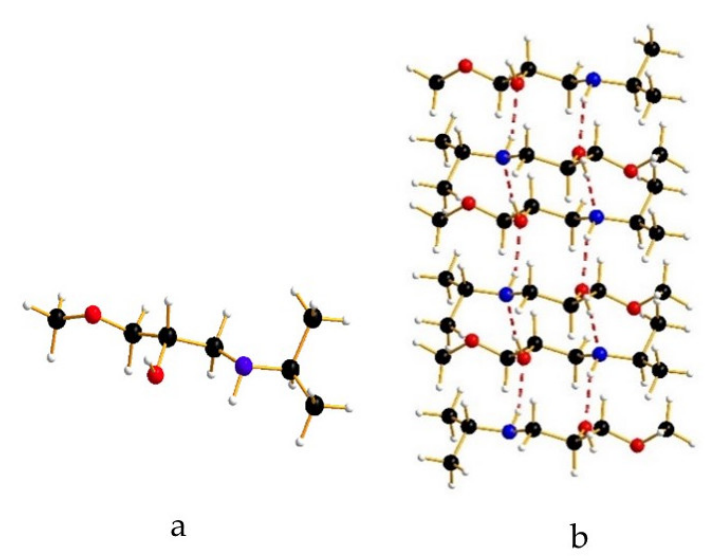
Figure 4. ( a ) Drawing of the simplified model, 1 ; ( b ) Optimized hydrogen bond column of 1 . The calculated equilibrium value for the column axis is 4.86 Å, a value consistent with the 5 Å identified as the limit for the elongation or shrinkage of the axis of the hydrogen bond column. Additionally, we optimized again the system fixing the axis between 4.20 Å and 5.50 Å. The energy variation is reported in Figure 5, showing how the shrinkage of the axis is more or less twice easier than its elongation.